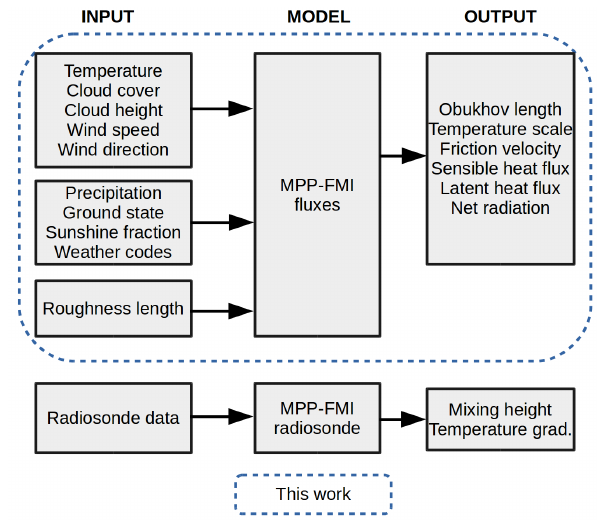
Figure 1. A schematic diagram on the flow of information of the meteorological preprocessor